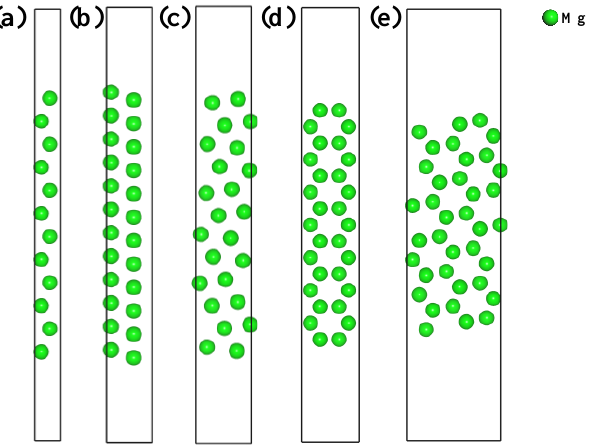
Figure 1. Configurations of different Mg surfaces: ( a ) basal (0001); ( b – d ) prismatic (1120), (213 0), (101 0); and ( e ) pyramidal (101